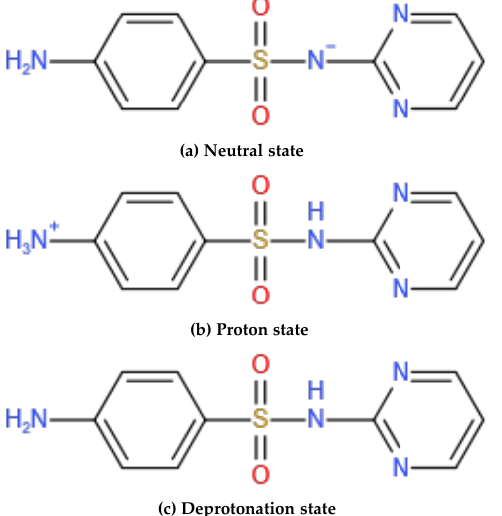
Figure 7. The structural formula of three forms of SDZ.